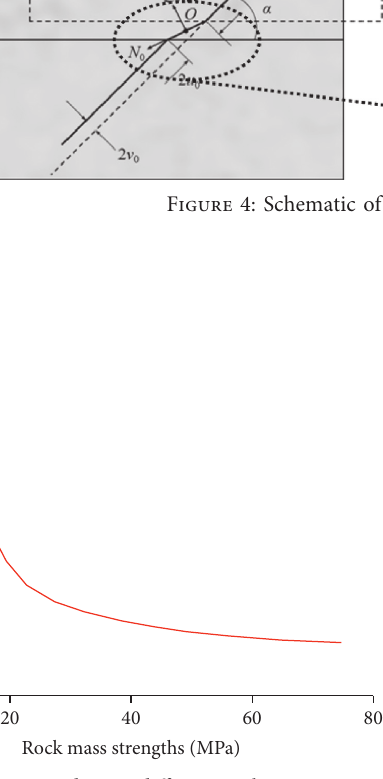
Figure 5: n values corresponding to different rock mass strengths